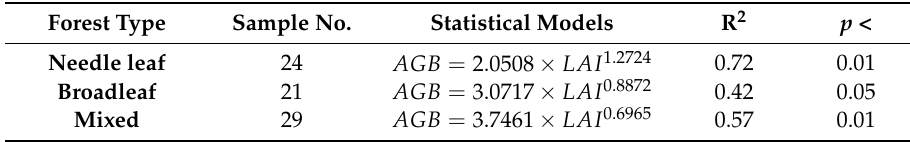
Table 3. The statistical models for forest field-based forest AGB and LAI for different forest types. Forest Type Sample